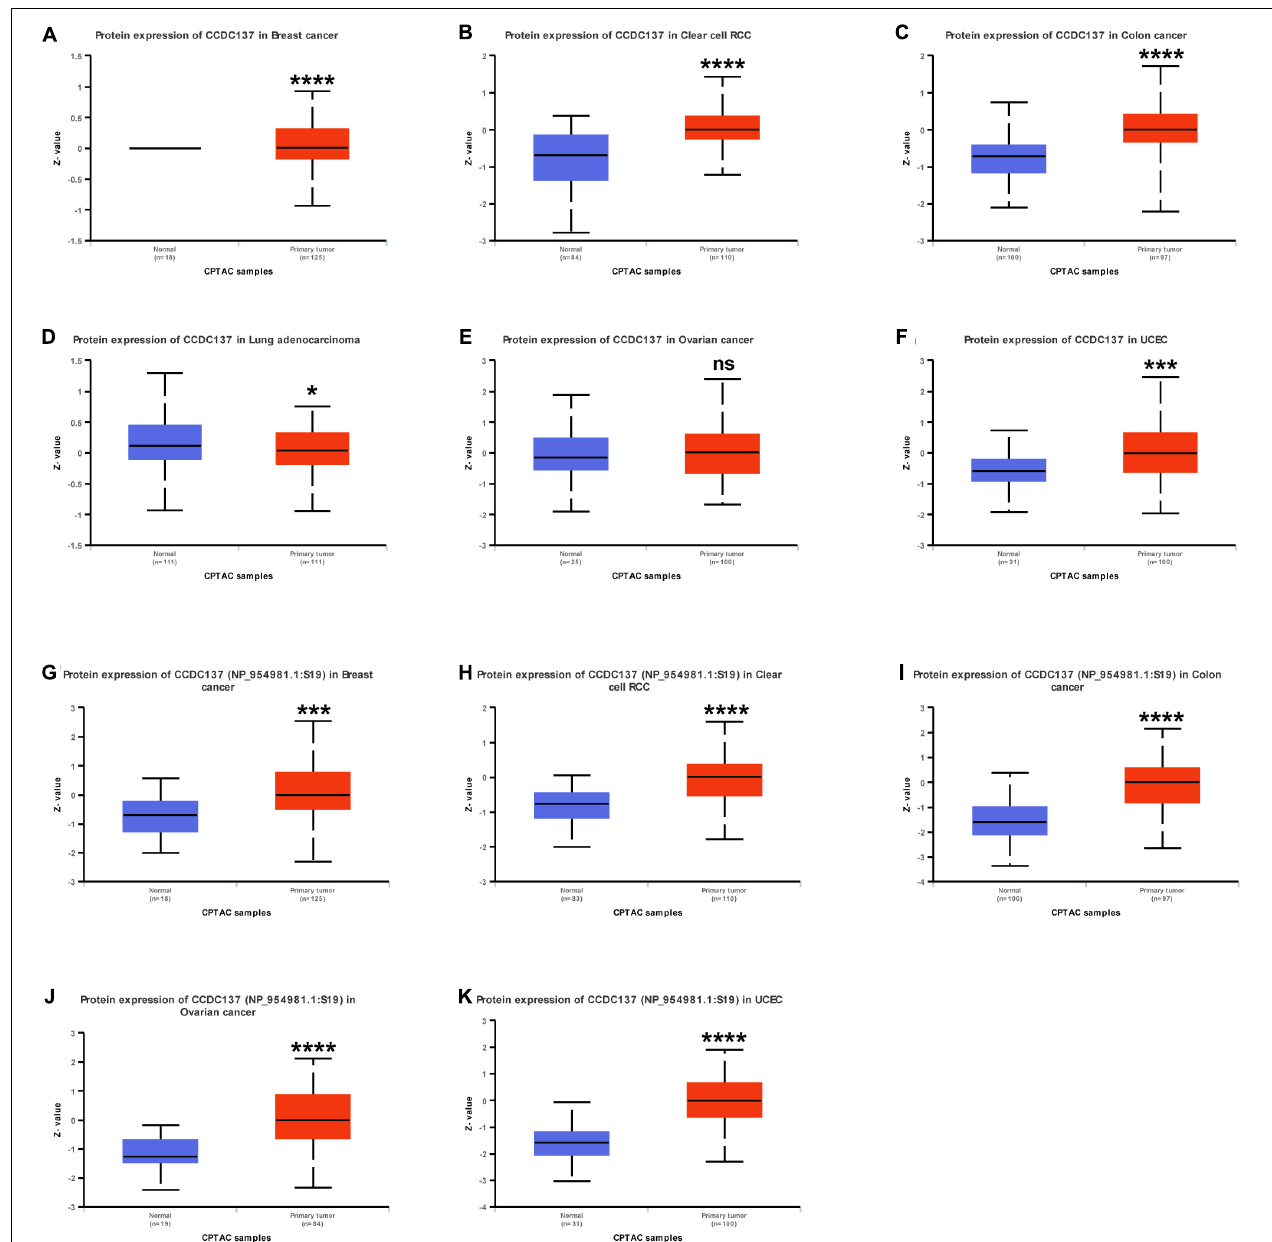
FIGURE 4 | Pan-cancer protein analysis of CCDC137. (A–F) CCDC137 protein level in indicated tumor types from TCGA cohort. (G–K) CCDC137 protein phosphorylation level in indicated tumor types from TCGA cohort. Data shown as mean ± SD. * p < 0.05, ** p < 0.01, *** p < 0.001, and **** p < 0.0001.